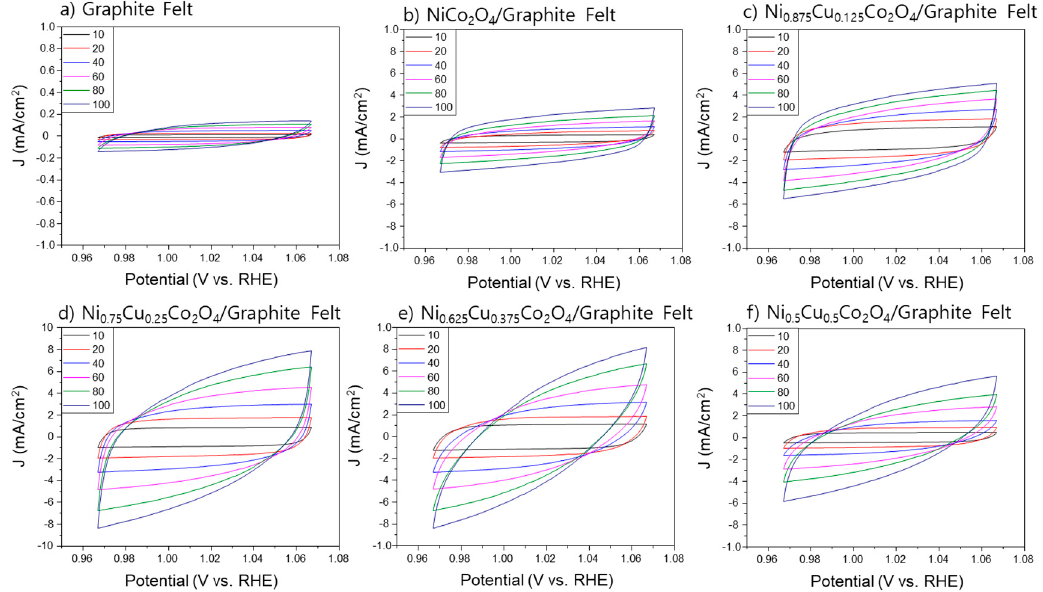
Figure 4. Cyclic voltammetry with scan rates in the non-faradaic region for all